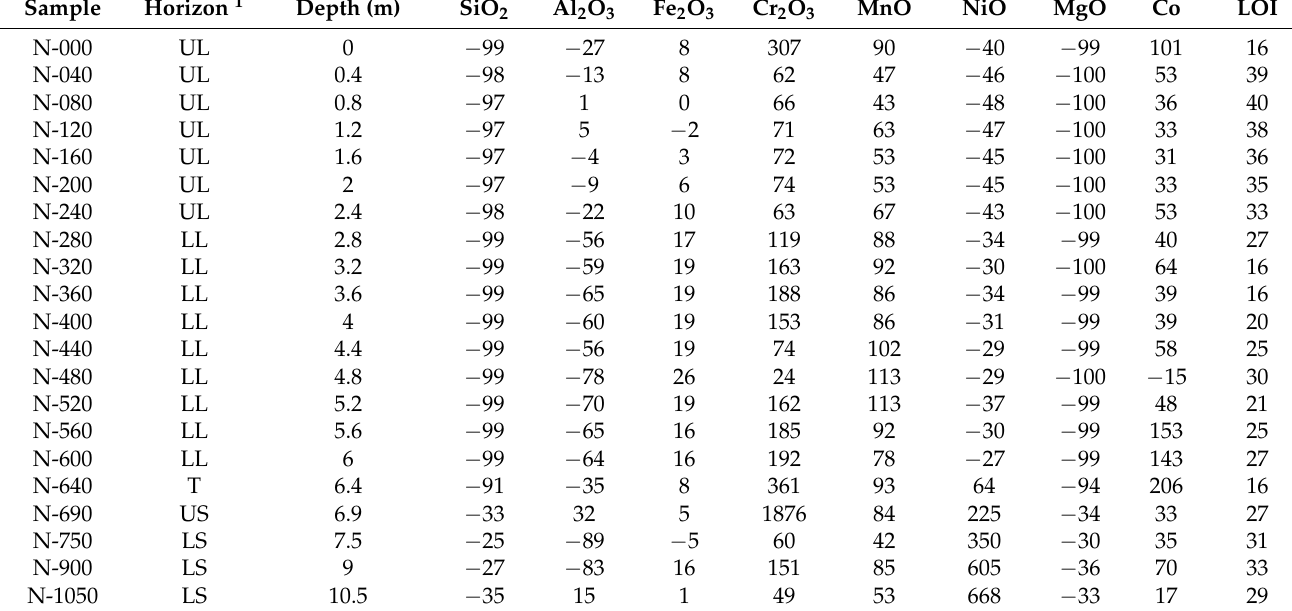
Table A2. Calculated relative mass changes of the samples from the Sta. Cruz